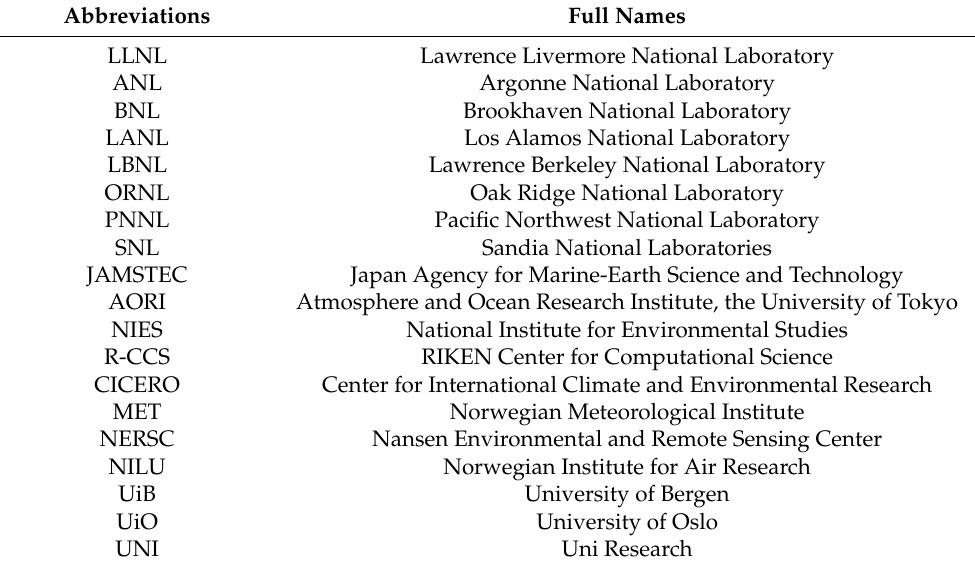
Table 2. Abbreviations for some institutes mentioned in Table